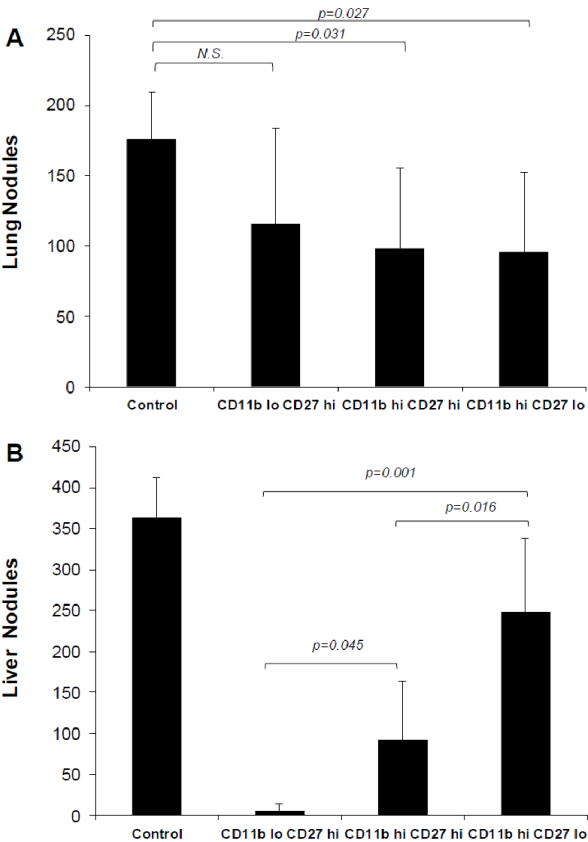
Figure 7. Adoptive transfer of liver NK cell subsets confers variable levels of protection against liver tumor establishment. c c/RAG 2 KO mice were injected i.v. with 5 6 10 4 sort-purified NK cells of the indicated subset phenotypes from the livers of wild-type C57BL/6 mice. Recipients were then inoculated intravenously with 3 6 10 5 melanoma cells. Fourteen days later lungs and livers were excised and tumors enumerated. Five recipients were used per group.